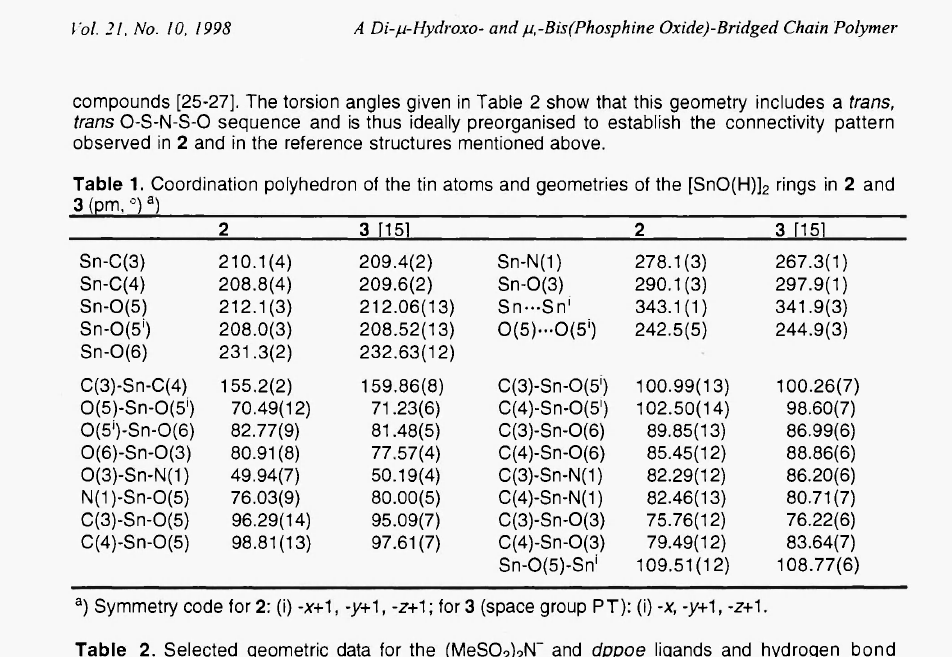
Table 2. Selected geometric data for the (MeS0 2 ) 2 N and dppoe ligands and hydrogen bond geometry in 2 (pm, °) a )